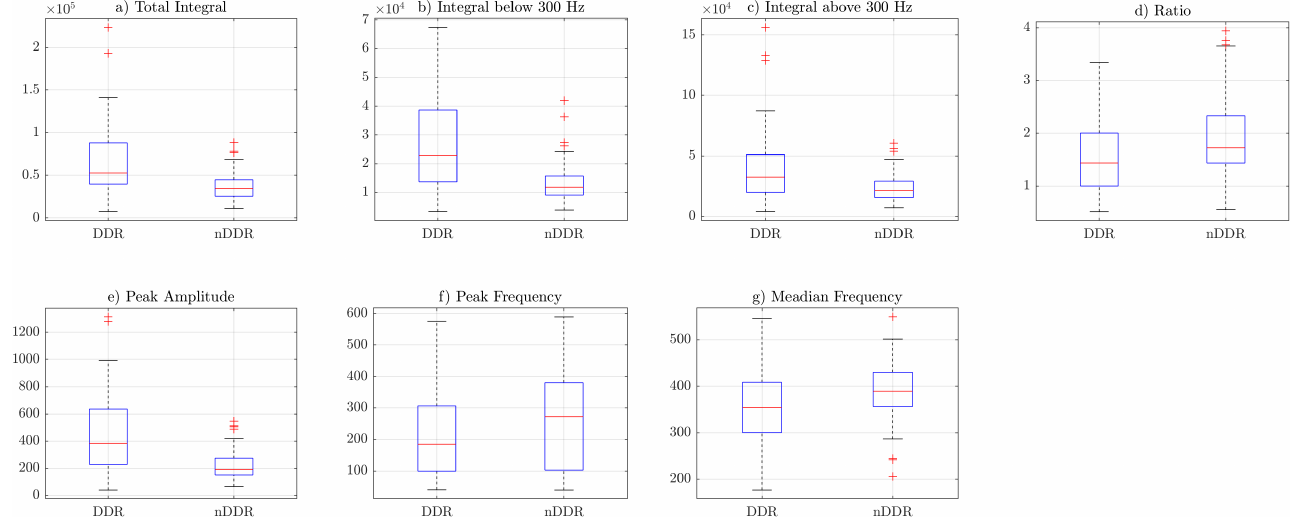
Figure 4. Boxplots of the norm1 features: ( a ) TI feature, ( b ) IB3 feature, ( c ) IA3 feature, ( d ) IBAR feature, ( e ) PA feature, ( f ) PF feature, ( g ) MF feature.